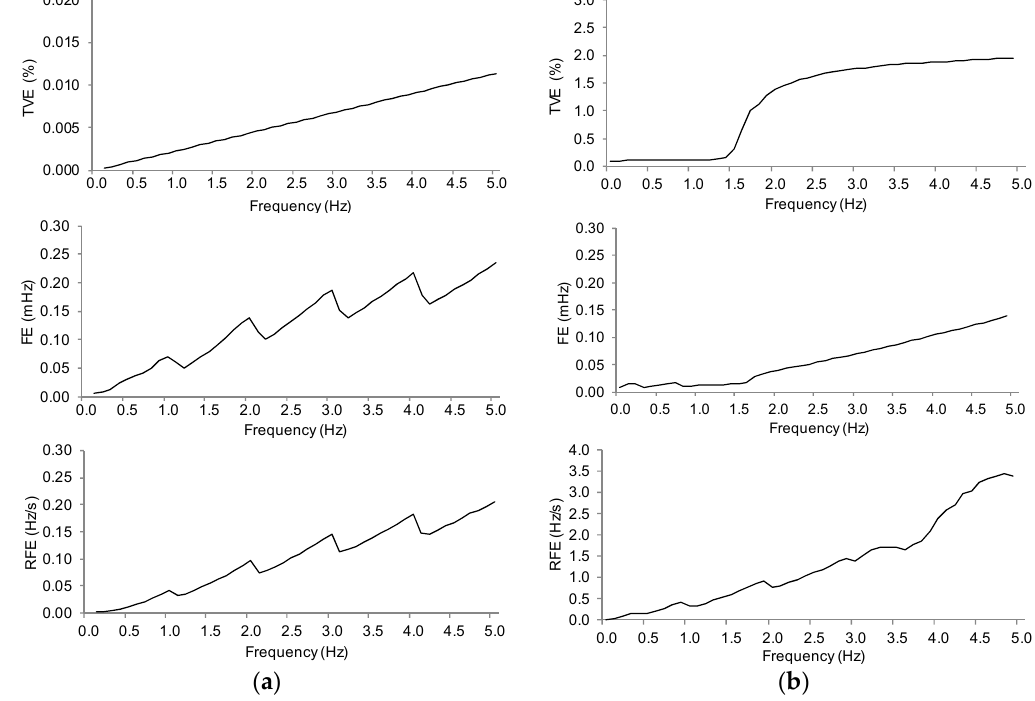
Figure 4. Effect of modulation frequency on maximum TVE, FE, and RFE for ( a ) amplitude modulation and ( b ) phase modulation tests.